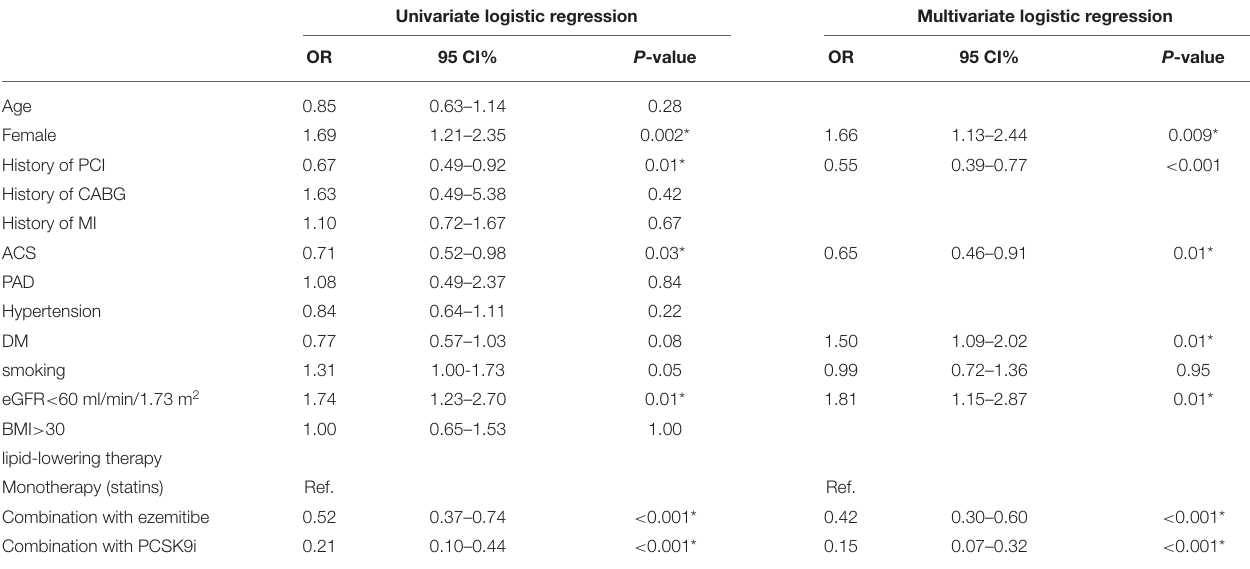
TABLE 4 | Factors impacting achieving LDL-C < 1.4 mmol/L goal for patients treated with